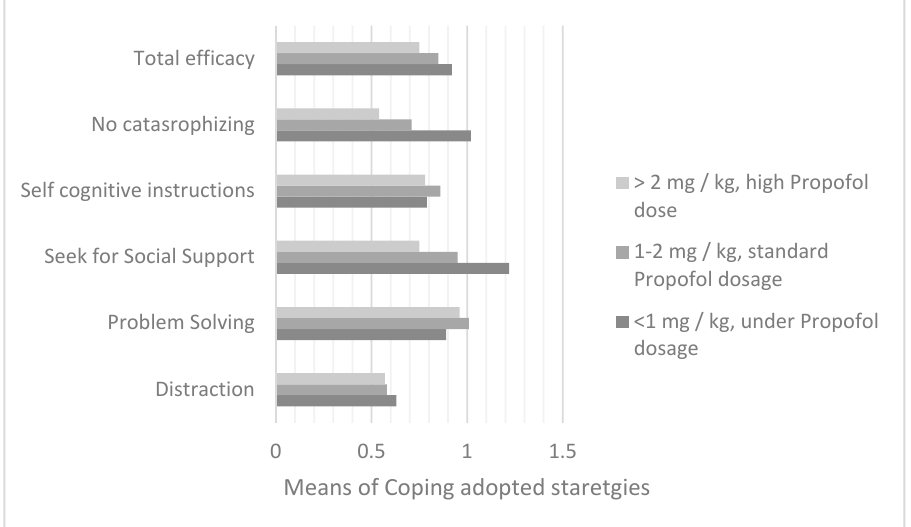
Figure 4. Comparison between the averages of the 5 coping strategies adopted along the average dosage of propofol taken in the sedation induction phase for the bone marrow aspirate of day +15. The same coping strategies of social support (F = 12; df = 2; p = 0.0001) and non- catastrophizing (F = 3.88; df = 2; p = 0.02) were found to be associated with the propofol dosage in the course of induction of sedation for aspirate of the day +33 (for ALL) or +21 (for AML), in a sample of 112 patients (Figure 5). With Bonferroni’s post-hoc test, these